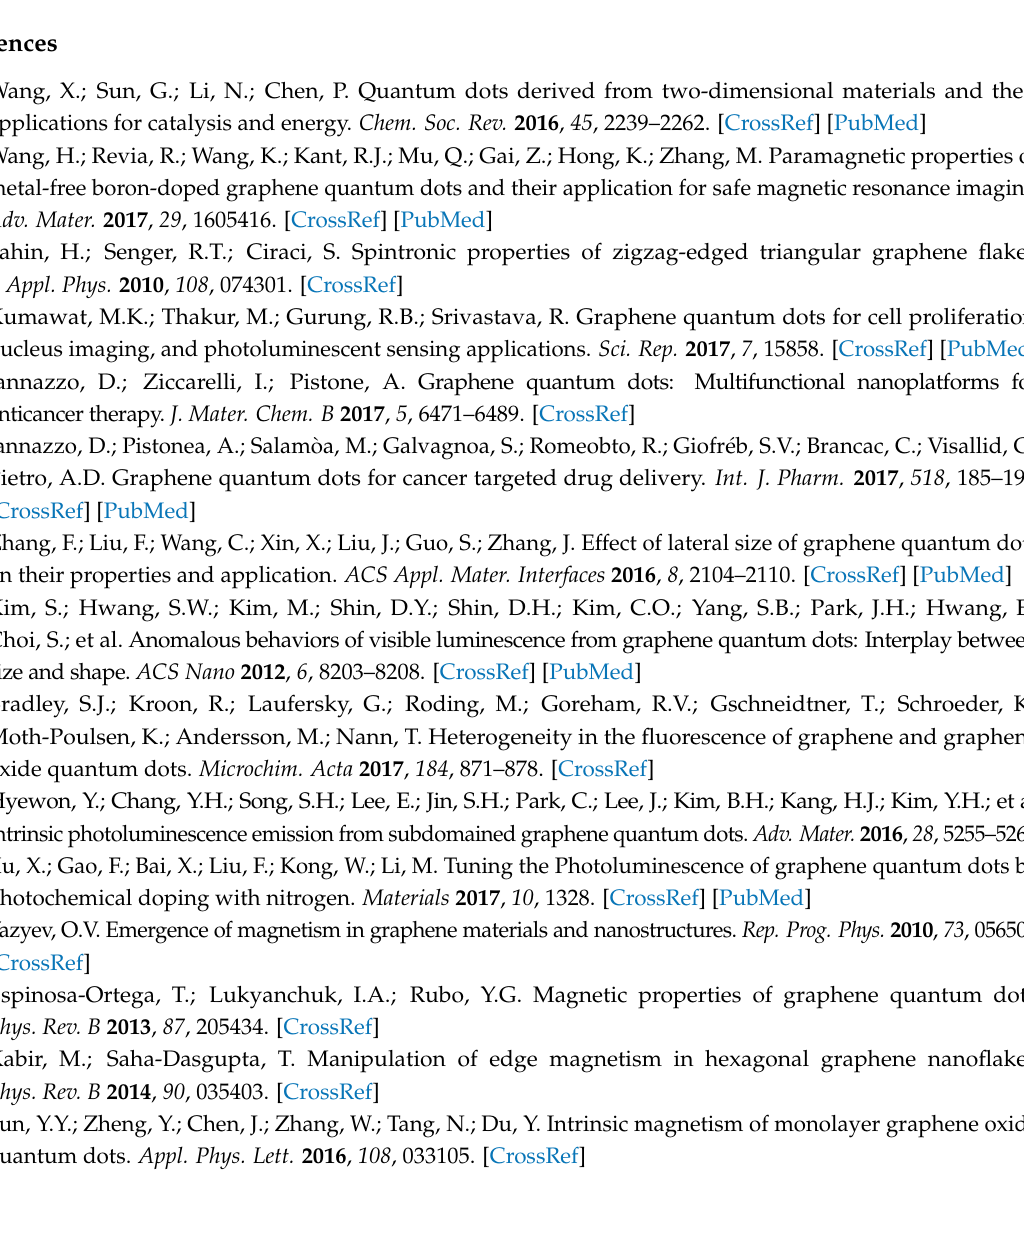
Figure S1: The size distribution of QGDs-F extracted by analysis of DLS data, Figure S2: The typical TEM images and C 1s XPS spectra of